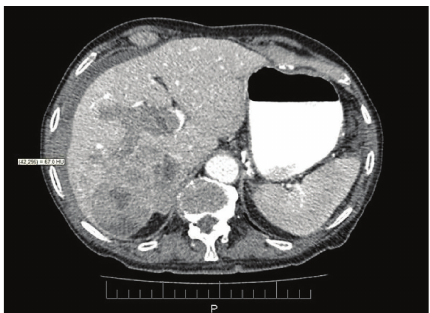
Figure 1: Abdomen CT showing a 7.5cm mass occupying the right lobe of the liver, thrombosis of the right portal vein, and hemoperitoneum (HU =